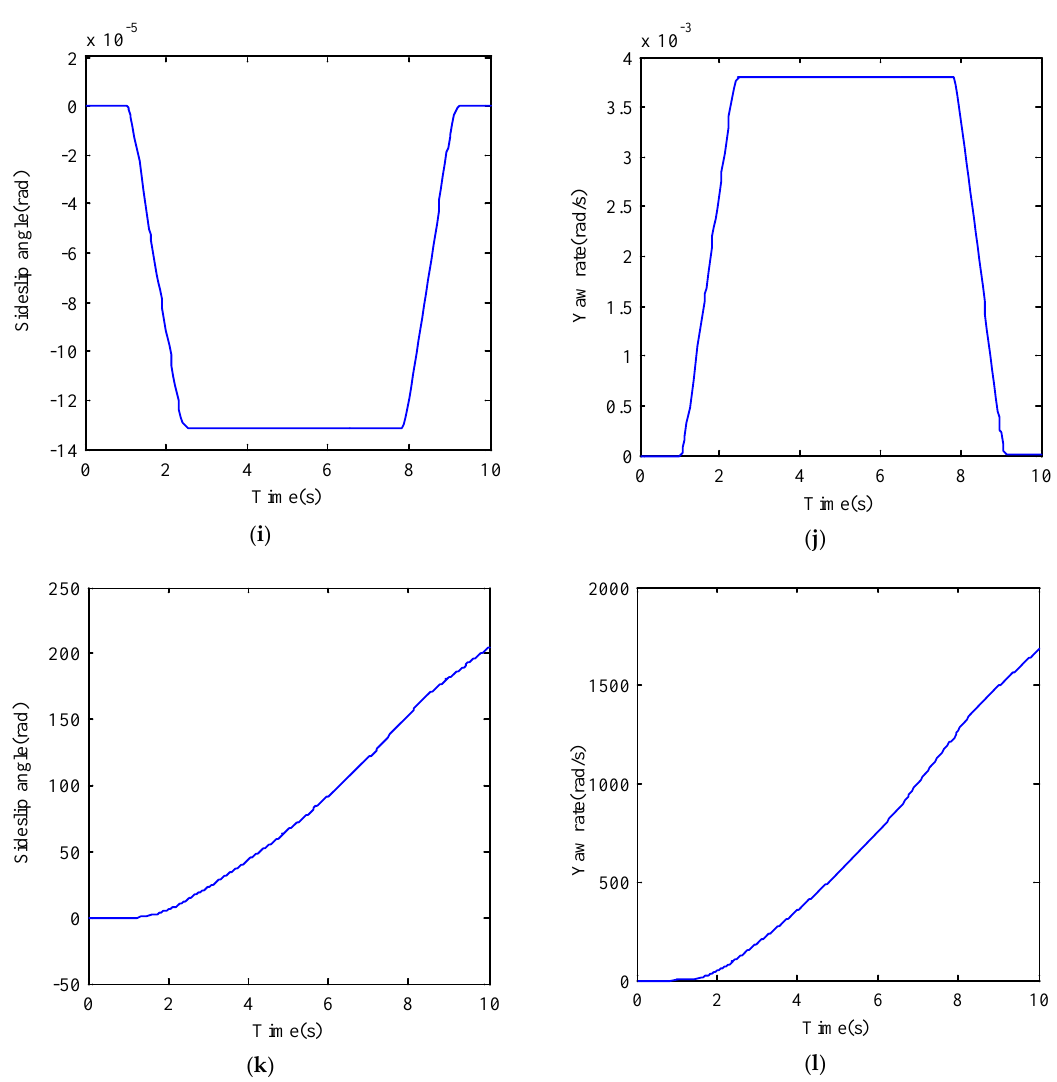
Figure 5. J-turn simulation at 10 m/s ( a ) Steering wheel steering angle curve; ( b ) Sideslip angle curves of skid steering vehicle (SSV); ( c ) Sideslip angle curves of DSV; ( d ) Yaw rate curves; ( e ) Sideslip angle curves; ( f ) Differential driving torque for skid steering; ( g ) Differential driving torque for differential steering; ( h ) Front wheel steering angle; ( i , j ) Response curves of SSV without sliding mode control (SMC) controller; ( k , l ) Response curves of DSV without SMC controller.